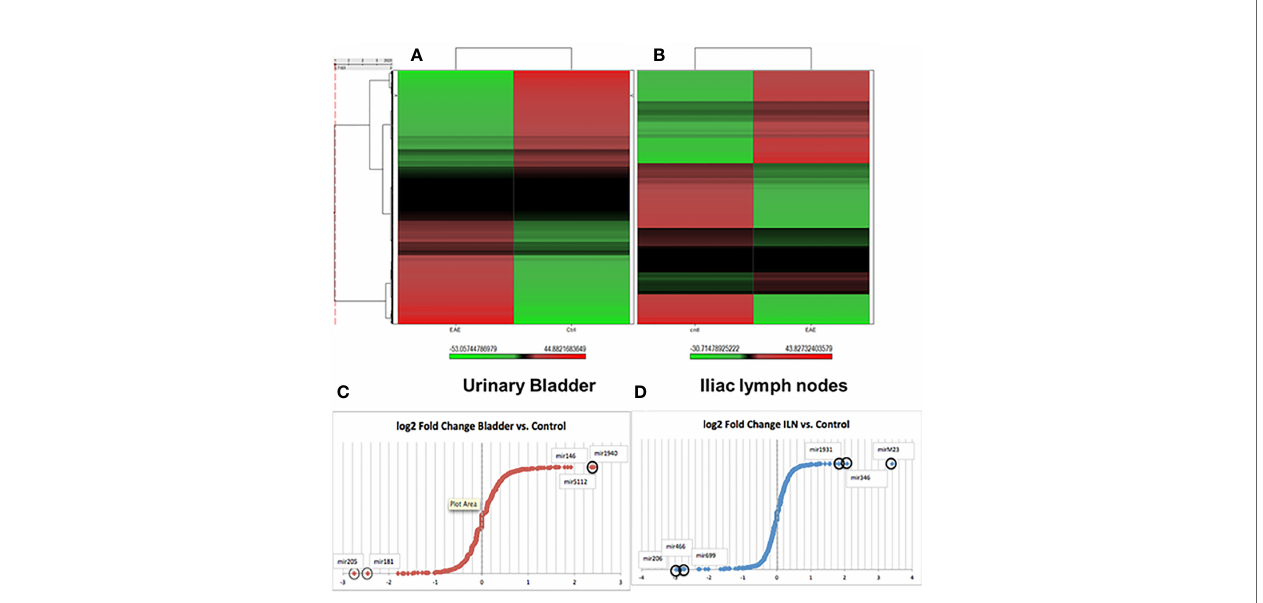
FIGURE 1 | Changes in unsupervised hierarchical clustering of differentially expressed miRs in a mouse model of IC versus normal controls between the urinary bladder and iliac lymph nodes tissue derived immune cells reveal divergent pathways. (A) Heat map of the miRs array done on immune cells from urinary bladder versus control. (B) Iliac lymph nodes vs. control. Red color indicates an upregulation, green color indicates a downregulation, and black color indicate no change. (C) Fold changes in urinary bladder normalized fold change (FC) in a mouse model of IC in Log2 scale. (D) Fold changes in iliac lymph nodes miRs expression normalized FC in a mouse model of IC in Log2